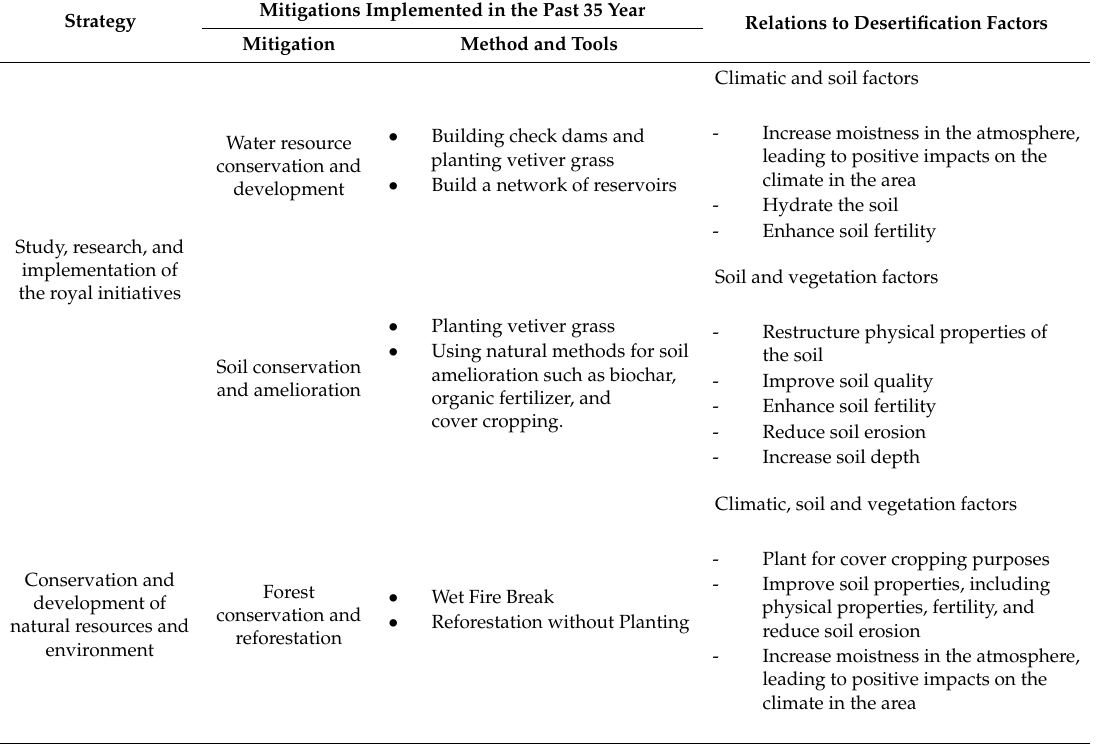
Table 4. Plan and mitigations of the HSRDSC and the relation to desertification